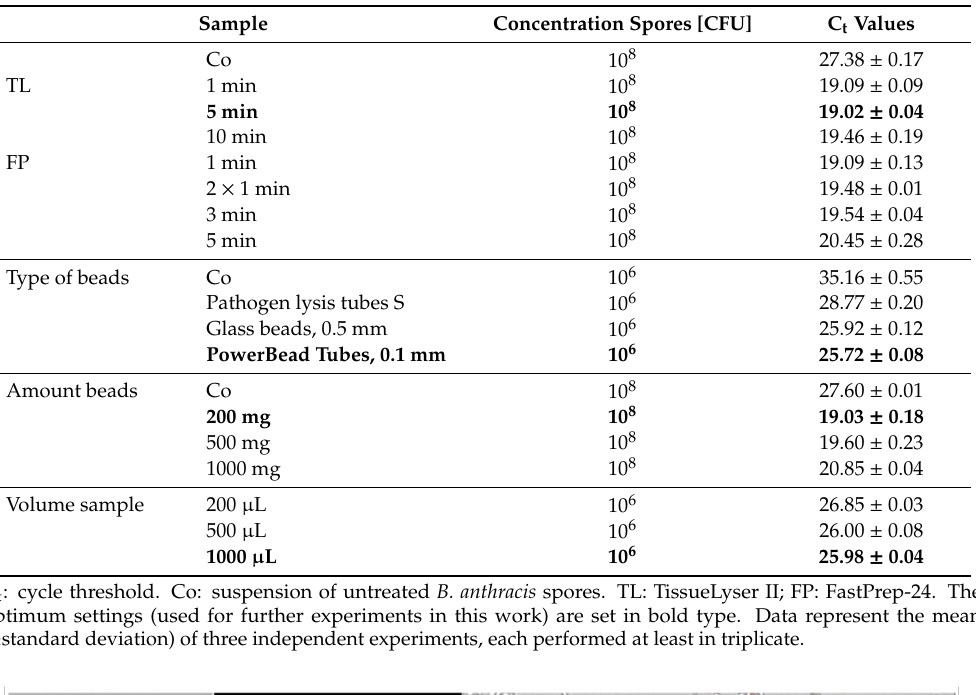
Table4. Bead-beatingconditionshaveahighimpactonlysise ffi ciencyof B.anthracis spores. Comparison of DNA release from B. anthracis spores, as quantified by qPCR after the disruption via bead-beating. Parameters (bead sizes and composition) as well as the homogenizer type on the e ffi ciency of cell disruption are shown.